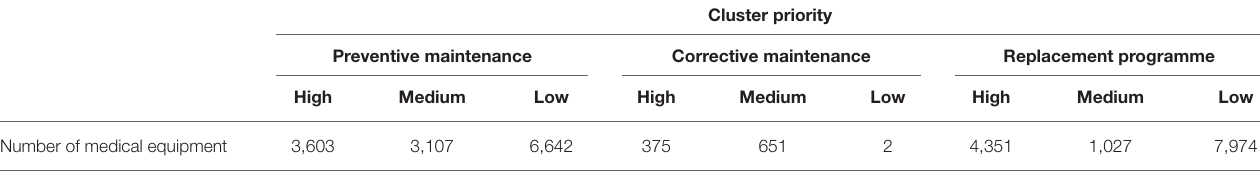
TABLE 6 | Medical equipment priority levels.